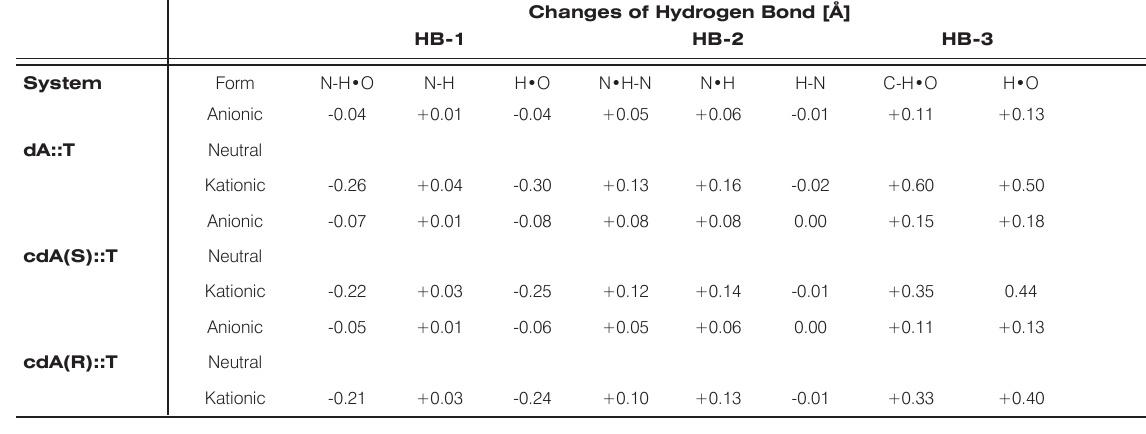
Table 5. The deviations in Å of hydrogen bond distances between cationic/anionic and neutral form of dA::T , cdA(S)::T , cdA(R)::T .